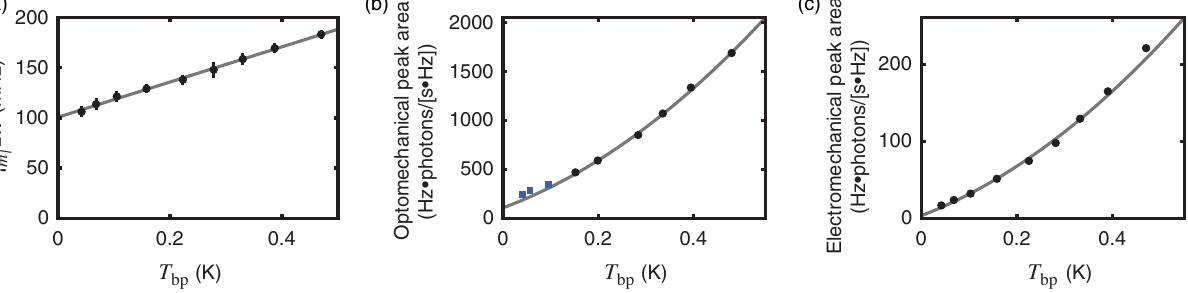
versus cryostat base plate temperature T , with linear fit. m bp . The quadratic fit (gray) calibrates the optical measurement chain bp in the absence bp